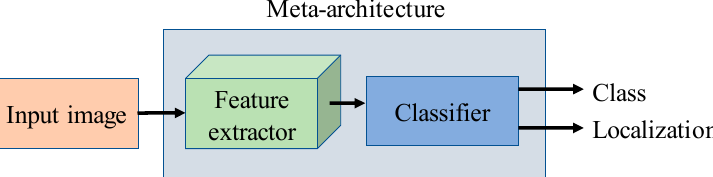
Figure 2. Flow chart of the deep meta-architecture approach used in this work. Our system proposes to treat a deep meta-architecture as an open system on which different feature extractors can be adapted to perform on our task. The system is trained and tested end-to-end using images captured in-place. The outputs are the class and localization of the infected area in the